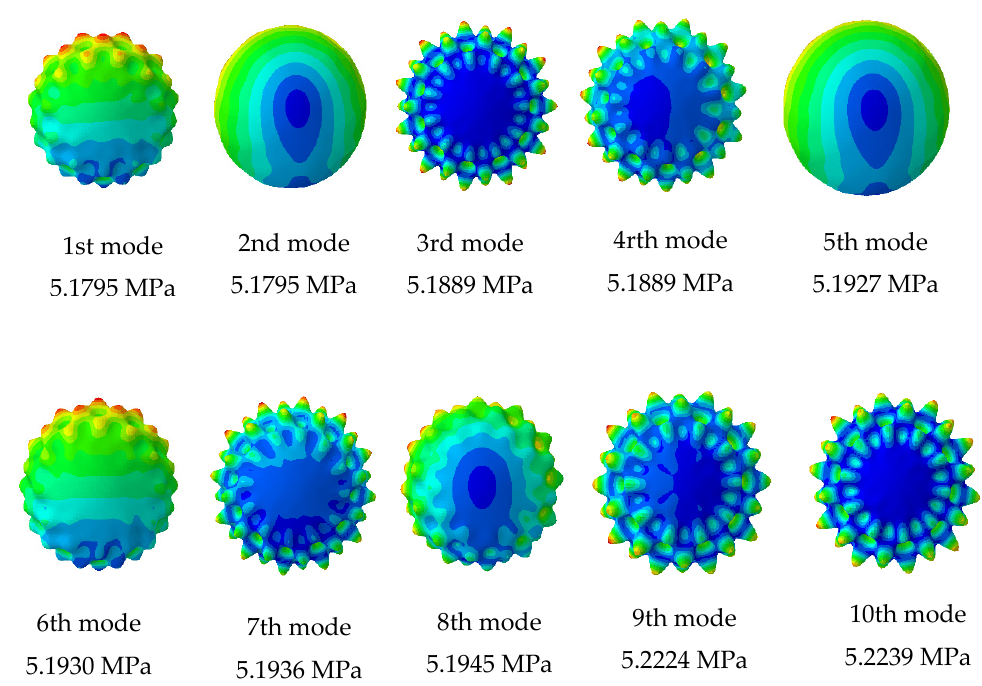
Figure 6. First 10 linear buckling modes of composite submersible spherical pressure hull.